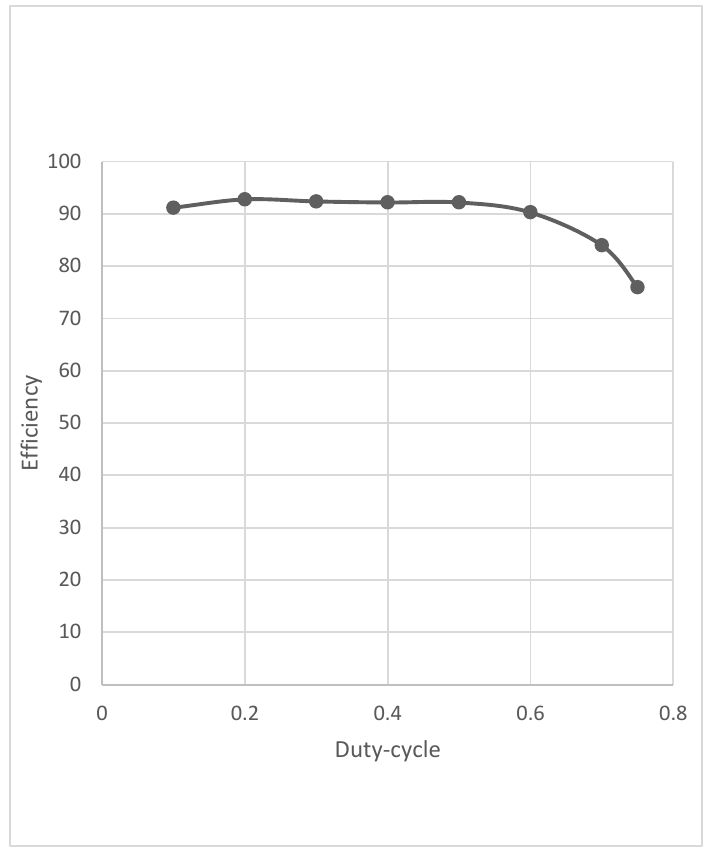
Figure 8. Efficiency versus duty-cycle plot of the 250 Watts prototype.